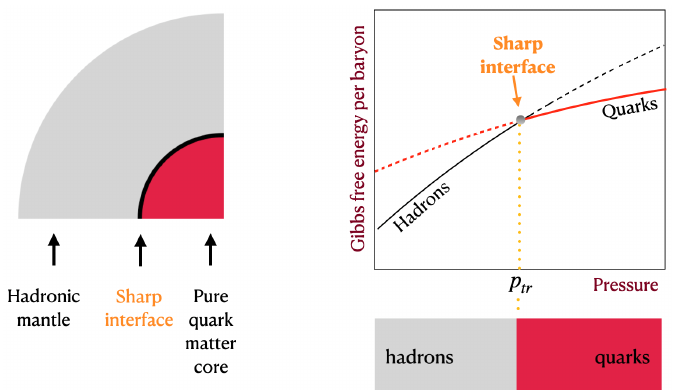
Figure 1. Sketch of the interior of a hybrid star and schematic representation of the Gibbs free energy per baryon in the case of a sharp